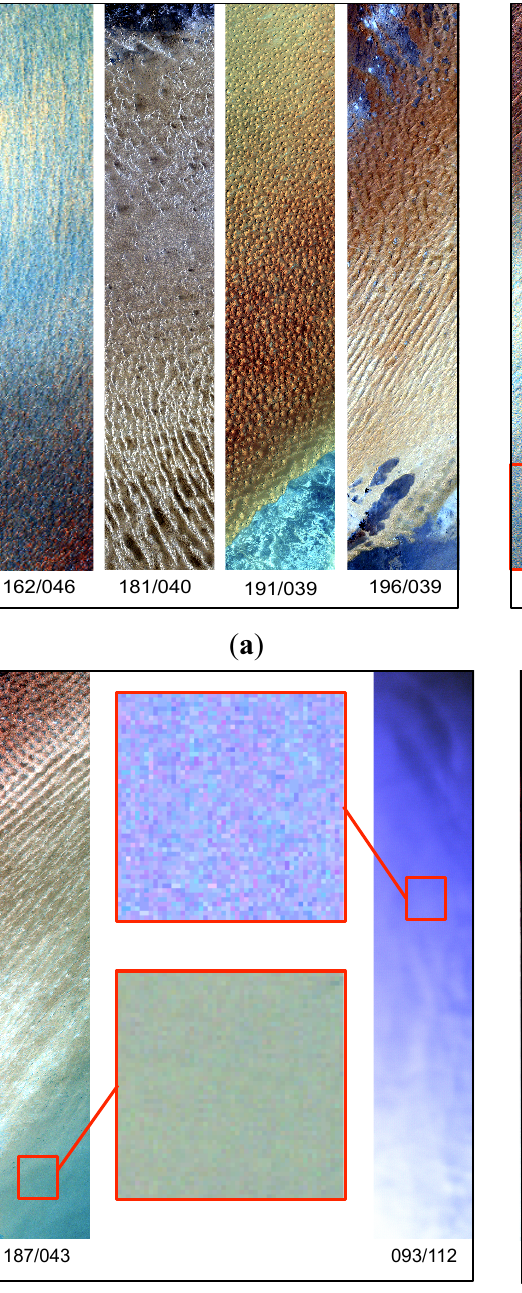
Figure 15. A visual comparison of the potential side slither sites tested in this work. ( a ) shows the sites that introduce the most error to the side slither-derived relative gains, ( b ) shows sites that introduce an acceptable error, and ( c ) shows the sites that introduce the least error. Note that sites whose image data resemble system noise introduce insignificant error to the process indicating that land features have minimal impact on the sensor-reaching signal. ( d ) shows additional side slither test sites that were chosen based on their visual